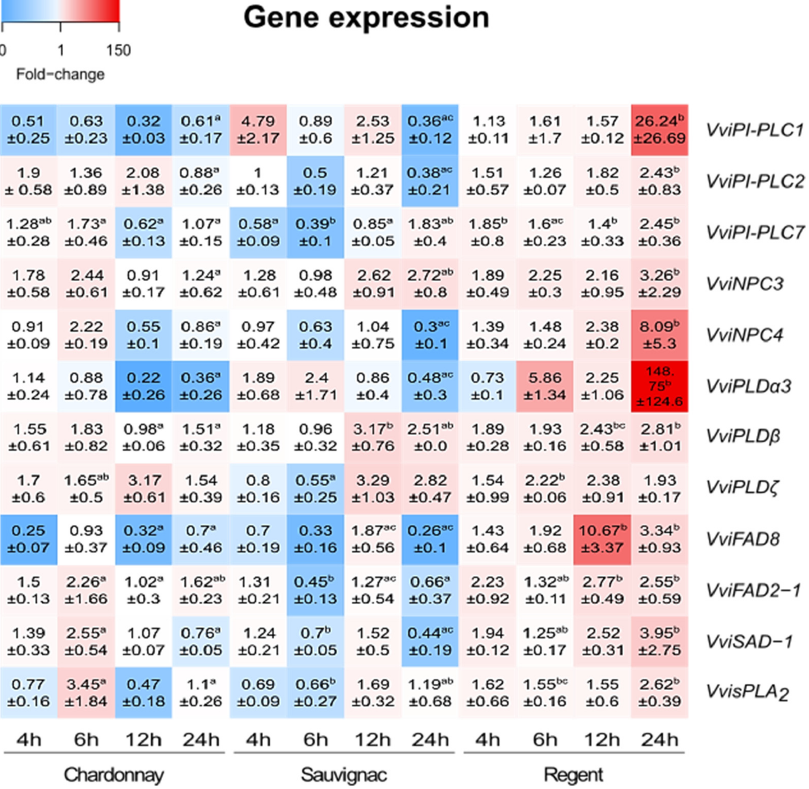
Figure 5. Heatmap representing the expression of VviPI-PLC1; VviPI-PLC2; VviPI-PLC7; VviNPC3; VviNPC4; VviPLD α 3; VviPLD β ; VviPLD ζ ; VviFAD8; VviFAD2-1; VviSAD-1 and VvisPLA 2 genes on each of the grapevine cultivars Chardonnay, Regent and Sauvignac. Fold change refers to the comparison between inoculated and mock-inoculated samples at 4, 6, 12 and 24 hpi. Blue indicates lower expression; red indicates higher expression and white indicates no expression (see colour scale). The statistical analysis was performed by Tukey’s multiple comparison tests. Lettering refers to comparisons between the expression of a specific gene between the genotypes at each time point.